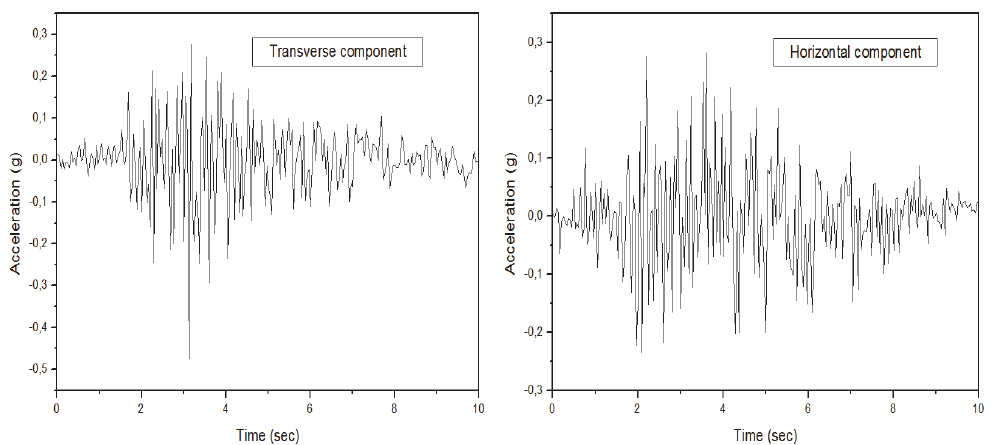
Figure 3: Koyna accelerograms a) Transverse component b) Vertical component